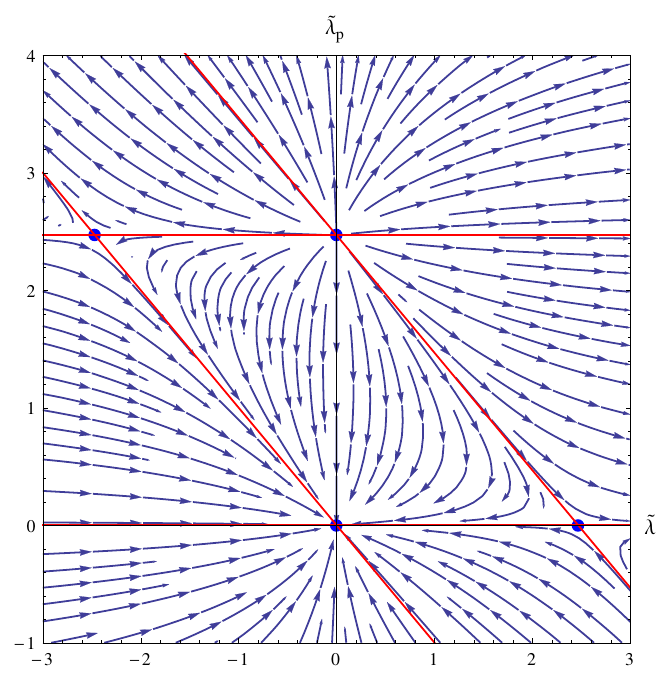
(cid:16) (cid:17) ~ (cid:21); ~ (cid:21) -plane. Arrows point towards the IR , blue p